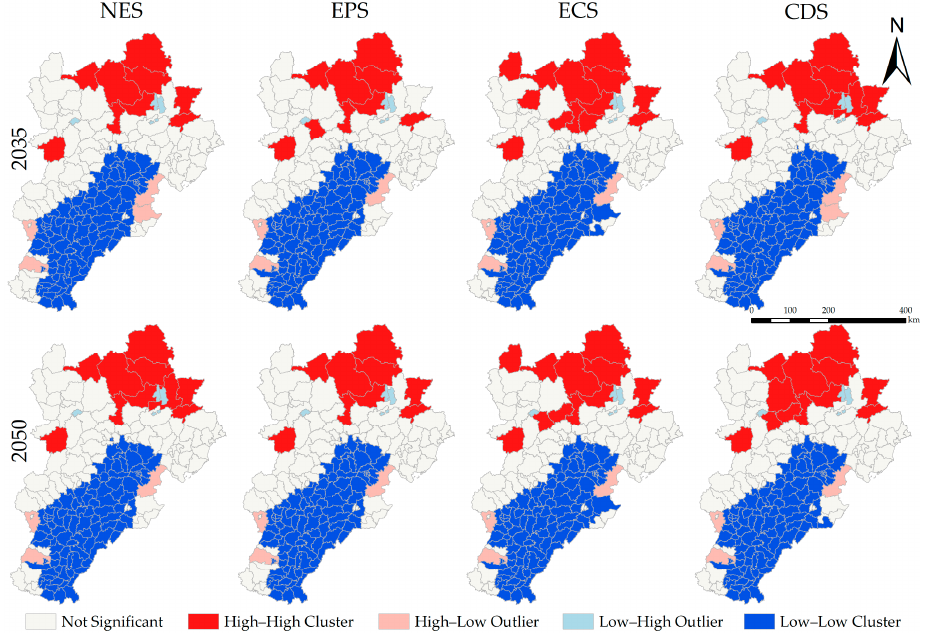
Figure 15. The local spatial autocorrelation analysis of carbon storage in 2035 and 2050 under four scenarios. four